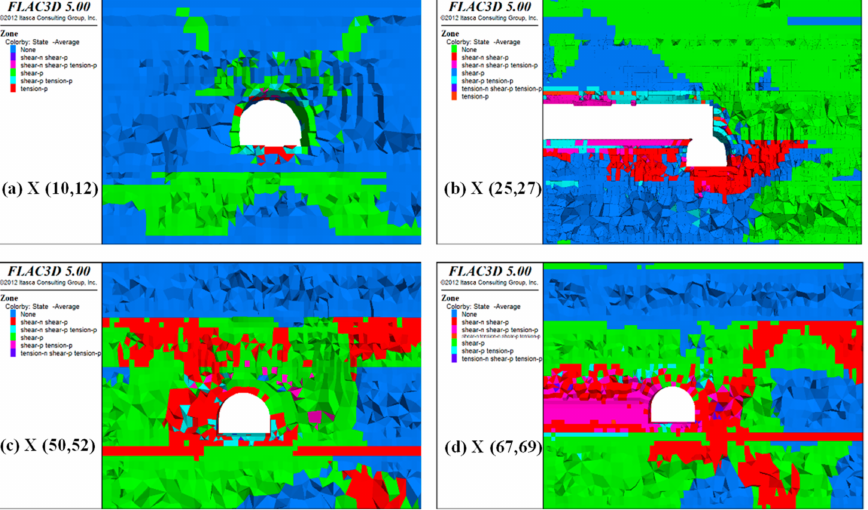
Figure 15. Plastic zone range of the four monitoring areas after excavation of head chamber in belt roadway.